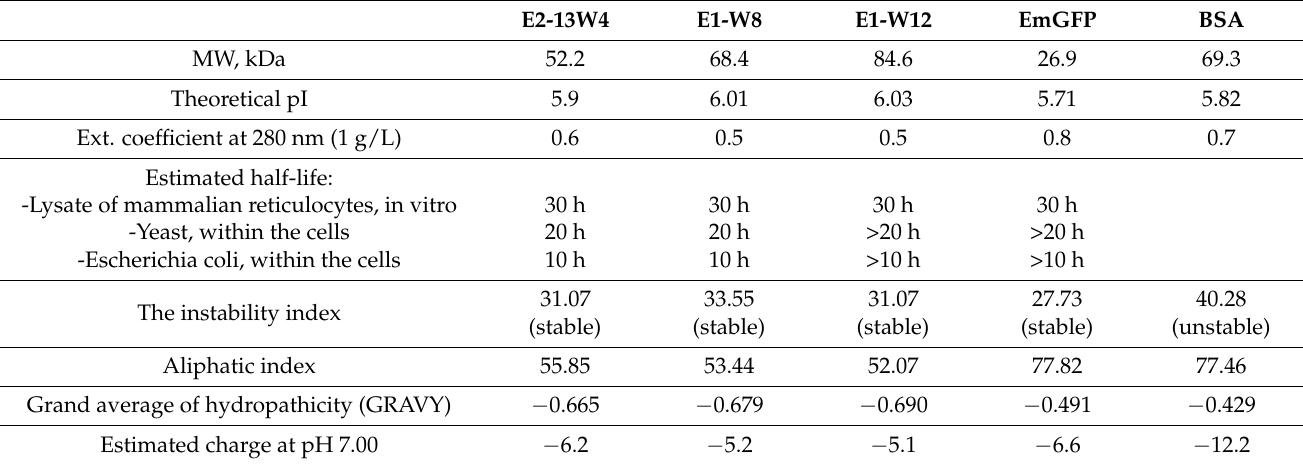
Table 1. The physical and chemical properties of the designed MBS-proteins compared with bovine serum albumin (BSA) (calculated by Protparam